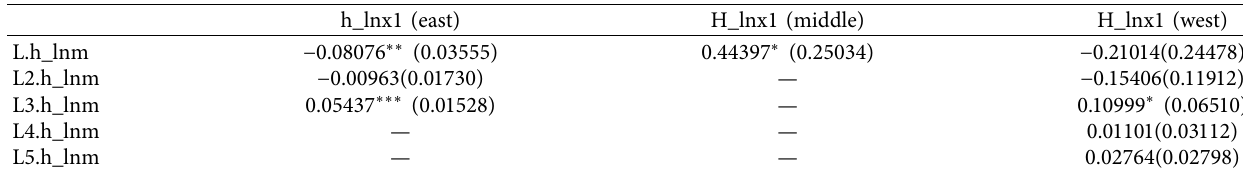
Table 13: GMM estimates of the eastern, middle, and western